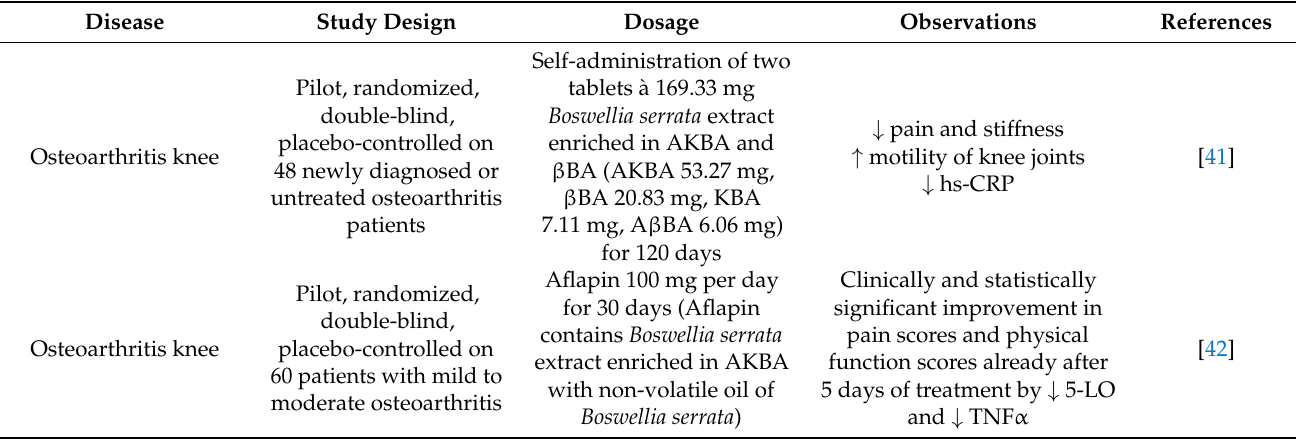
Table 2. Overview on the randomized, double-blind, placebo-controlled clinical trials addressing the efficacy of frankincense extracts in different diseases associated with